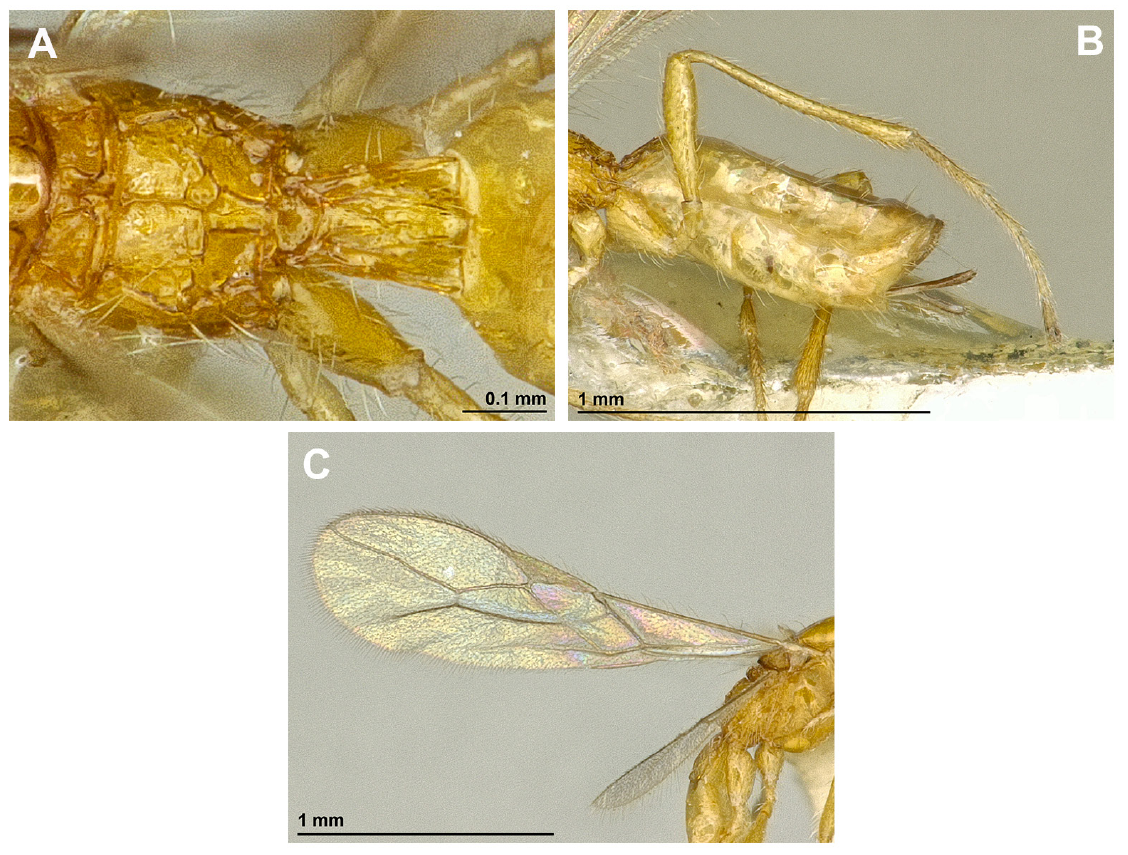
Fig. 79. Asobara zimbabwana Peris-Felipo, sp. nov., ♀, holotype (BMNH). A . Propodeum and first metasomal tergite, dorsal view. B . Hind leg, metasoma and ovipositor, lateral view. C . Fore and hind